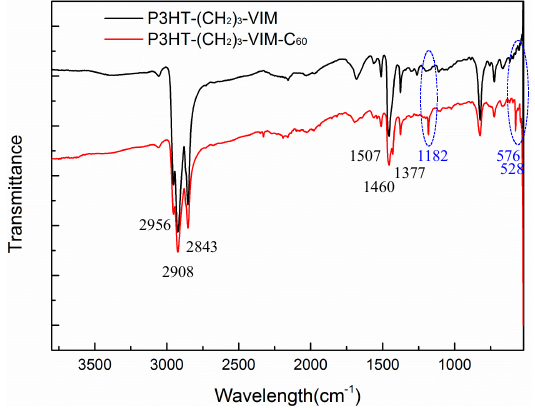
Figure 11. Overlay of FT-IR spectra of P3HT-(CH 2 ) 3 -VIM and P3HT-(CH 2 ) 3 -VIM-C 60 .